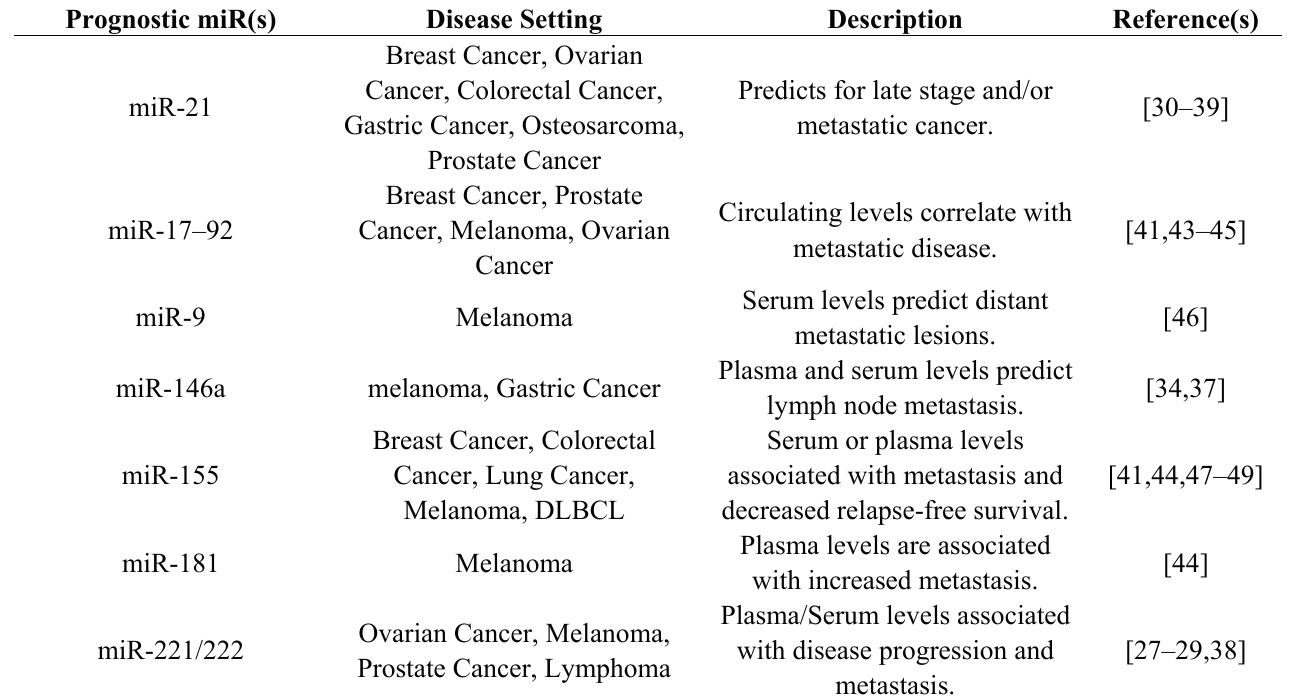
Table 2. MicroRNAs with potential as circulating biomarkers for predicting prognosis of cancer. Prognostic